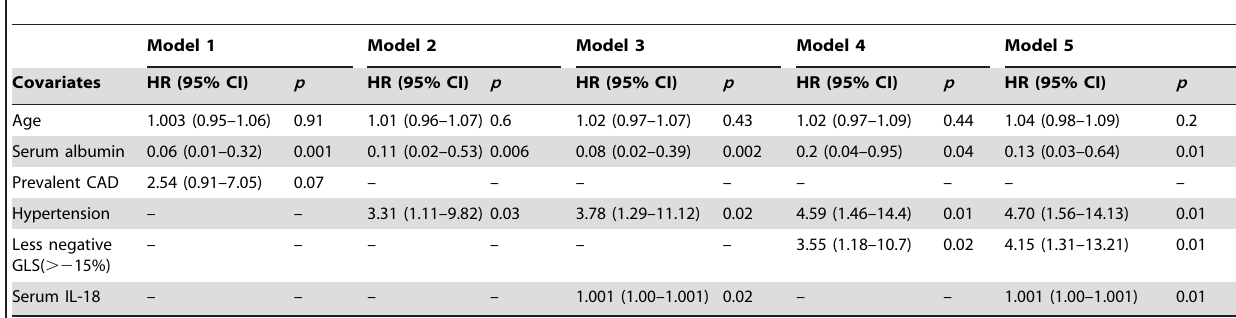
Table 6. Multivariate Cox regression analysis for all-cause mortality in stable hemodialysis